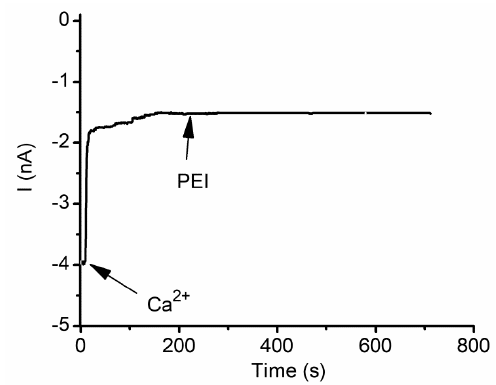
Figure 12. Multivalent ions and cationic polymers compete for the binding sites present in the lysenin channel’s structure. After channel blockage and transition to sub-conducting states by Ca 2+ addition (40 mM final concentration), PEI (10 µM final concentration) does not show further inhibition of the ionic currents. Published under Creative Commons Attribution License in [63].